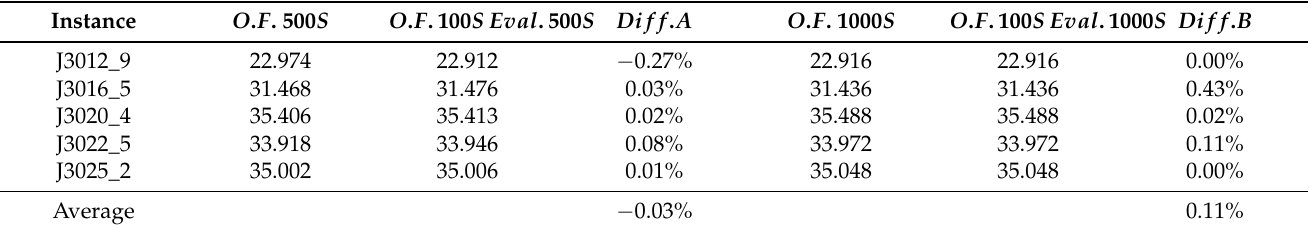
Table 17. Experiment 4 results. Evaluation of the 100 scenarios solution in the 500 and 1000 scenarios. Thirty activities